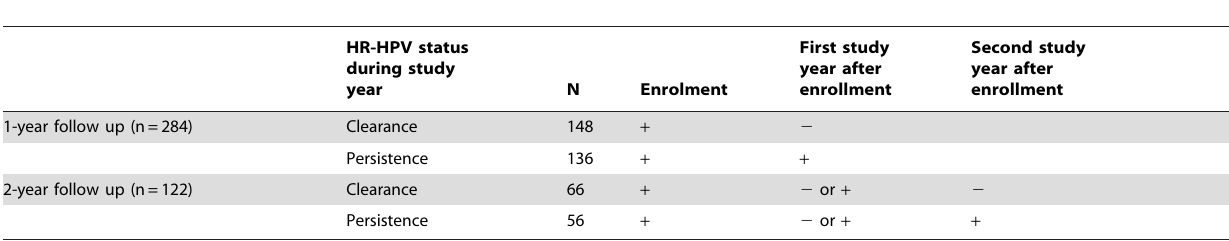
Table 1. Definition of study groups for the persistence of high risk-human